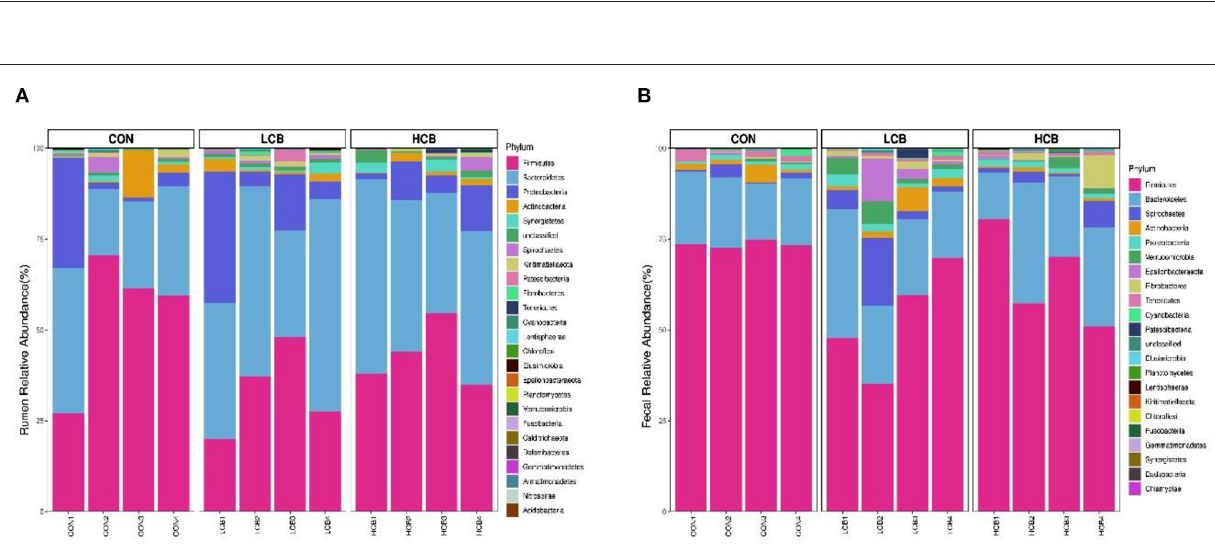
FIGURE 3 | Stacked bar graph displays a comparison of microbial relative abundance (%) at phylum level among main effects of treatments in rumen (A) and fecal (B) of fattening goats. The label CON denotes without prebiotics, the label LCB denotes low-dose C. butyricum, and the label HCB denotes high-dose C. butyricum for each sample. The letters (1,2,3 and 4) denote replicate samples. CON: 0 CFU C. butyricum per kilogram feed, LCB: 2.0 × 10 8 CFU C. butyricum per kilogram feed, HCB: 1.0 × 10 9 CFU C. butyricum per kilogram